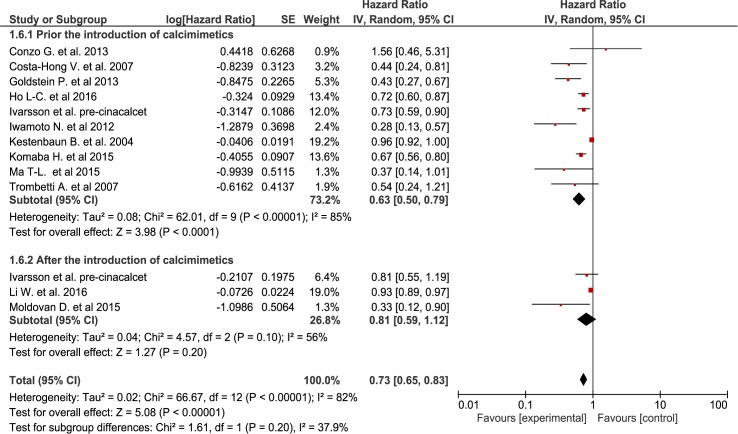
Subgroup analysis according to the moment of calcimimetics introduction.